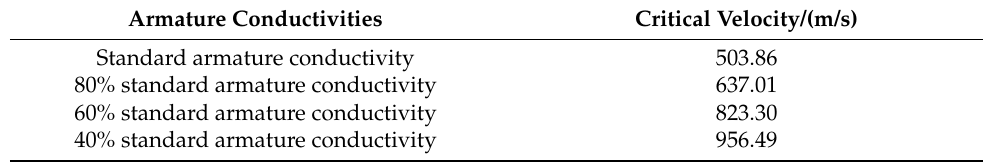
Table 3. Critical velocity for stable numerical simulation at different armature conductivities.